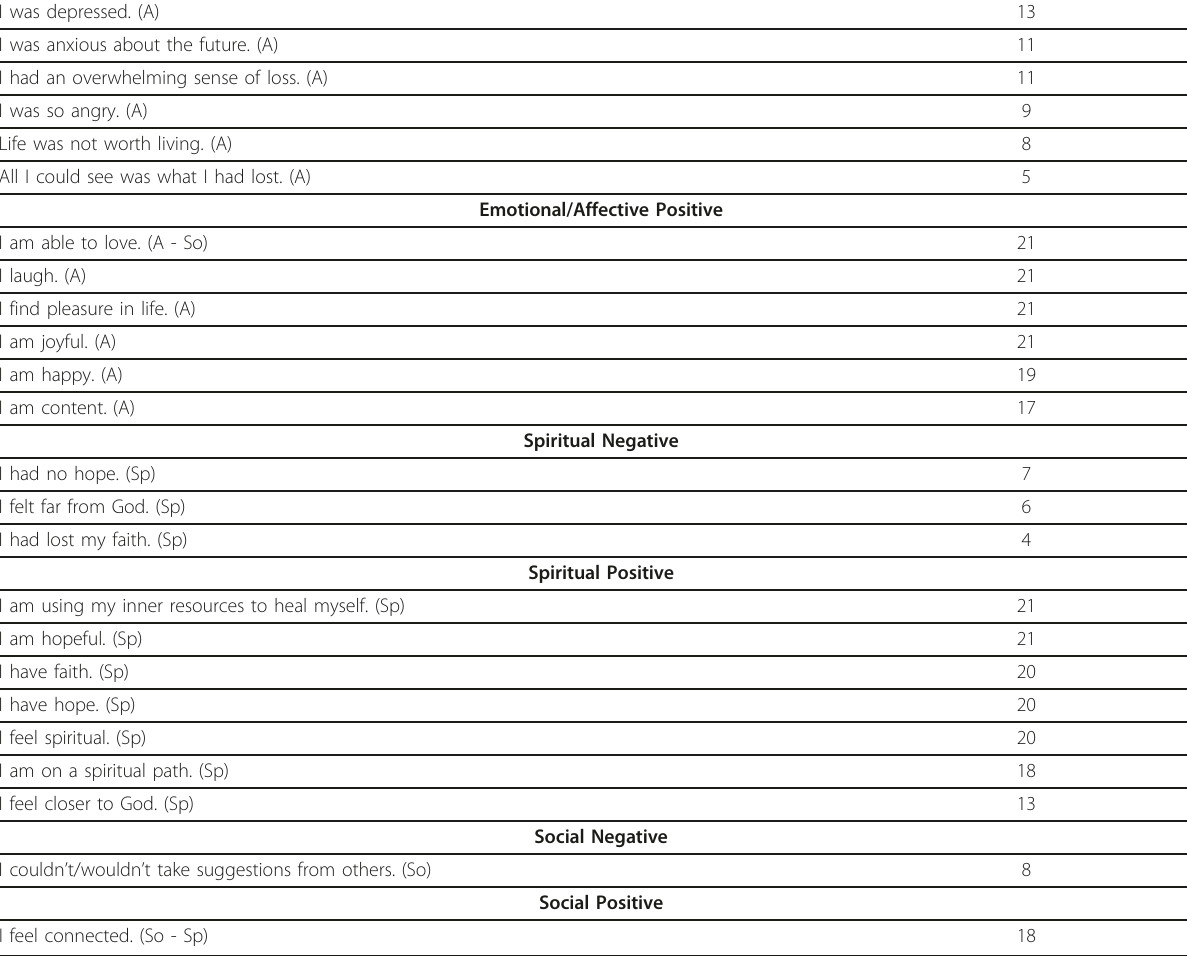
Table 4 Complete List of Positive and Negative Items by Level of Endorsement* Sorted by Psychometric Domains